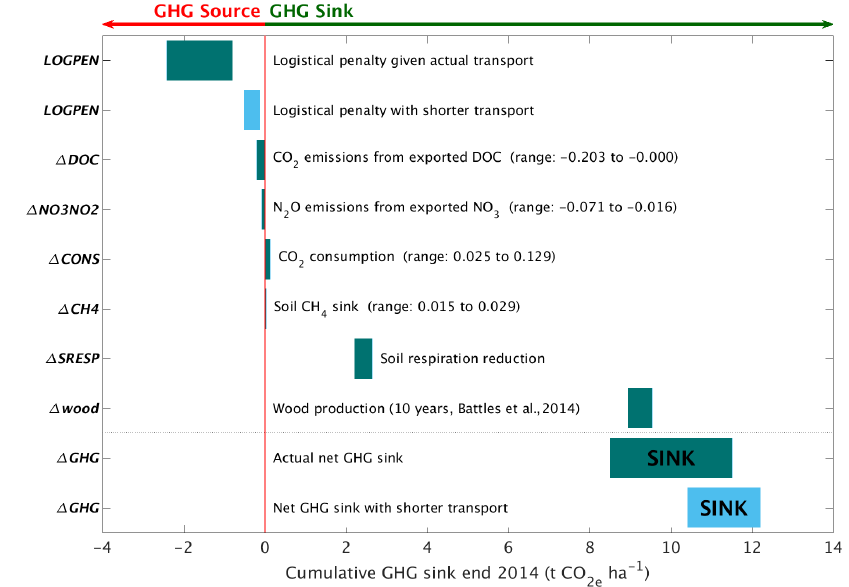
Figure 5. Carbon responses for the wollastonite treatment. Elements of the greenhouse gas balance associated with the wollastonite treatment (Table 4). The CO 2 consumption range is given by Wo-CO 2 , HCO calculated by Eq. (3) and Wo-CO 2 , Ca calculated by Eq. (4), time-integrated 3 from the application date through 2014. Nitrate export in stream water leading to N 2 O greenhouse gas emissions downstream and a small increase in the soil CH 4 sink have been converted to CO 2 equivalents (Methods). Exported DOC is assumed to be respired downstream.